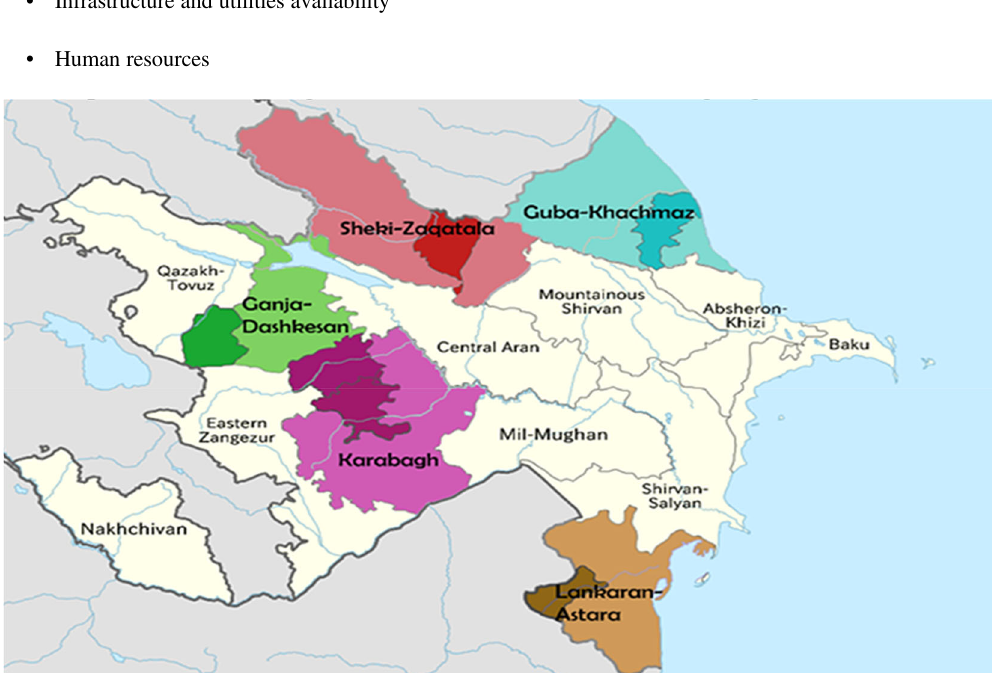
Figure 1. Map of Azerbaijan Republic with studied regions (Source: